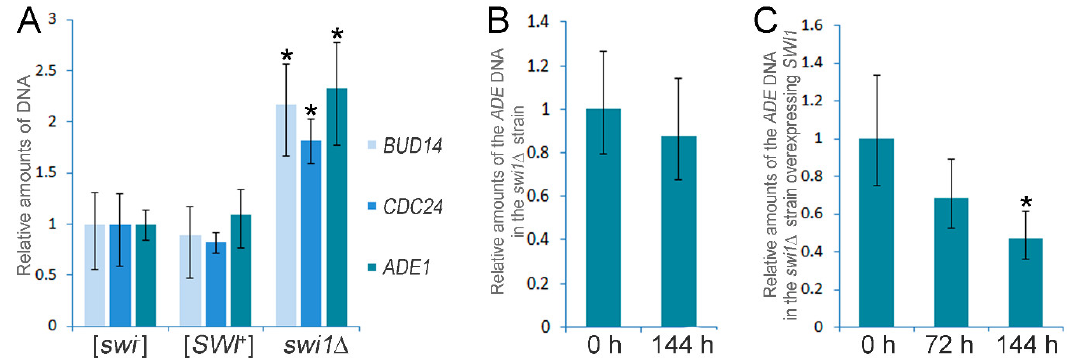
Figure 3. qPCR verification of the Chromosome I disomy in the swi1 Δ strain and analysis of its stability and elimination. ( A ) Comparative qPCR analysis of the ADE1 , BUD14 , and CDC24 genes copy number in the [ SWI + ], [ swi − ], and swi1 Δ strains is shown. ( B ) Analysis of the stability of the Chromosome I disomy in the swi1 Δ strain ( ADE1 was used as the marker of the chromosome I copy number). (C) The effects of the SWI1 expression in the swi1 Δ strain on the Chromosome I copy number ( ADE1 was used as the copy number marker). In all experiments, qPCR was performed using genomic DNA of the corresponding strain as the template and primers and probes listed in the Table S1. Yeast cells were grown on the complete media at 30 °C for the indicated time. The ACT1 gene was used as a control. The results are shown as the 2 −ΔΔ C t ± the standard deviation. The means of the 2 −ΔΔ C t in the control samples or at the initial points of the experiments were set as 1. Five biological repeats were obtained for each experiment. The significance of the differences observed was analyzed with the nonparametric Kruskal-Wallis test. Asterisk indicates p ≤ 0.01.